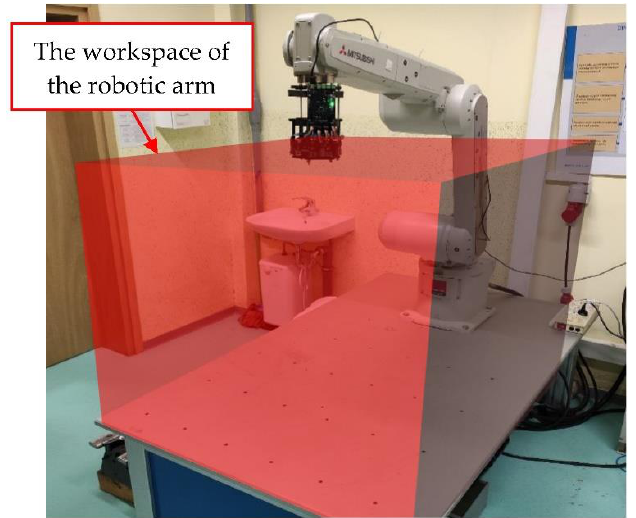
Figure 3. The workspace of the Mitsubishi robotic marked with a red cuboid.